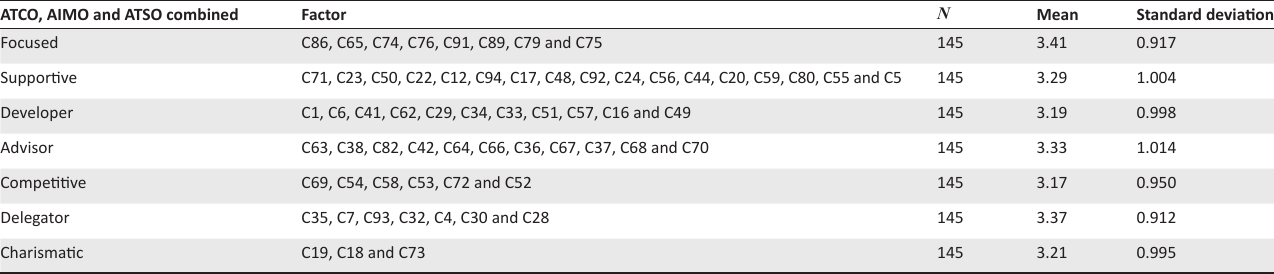
TABLE 5: Leader behaviour factors and items (noted as ‘C’).